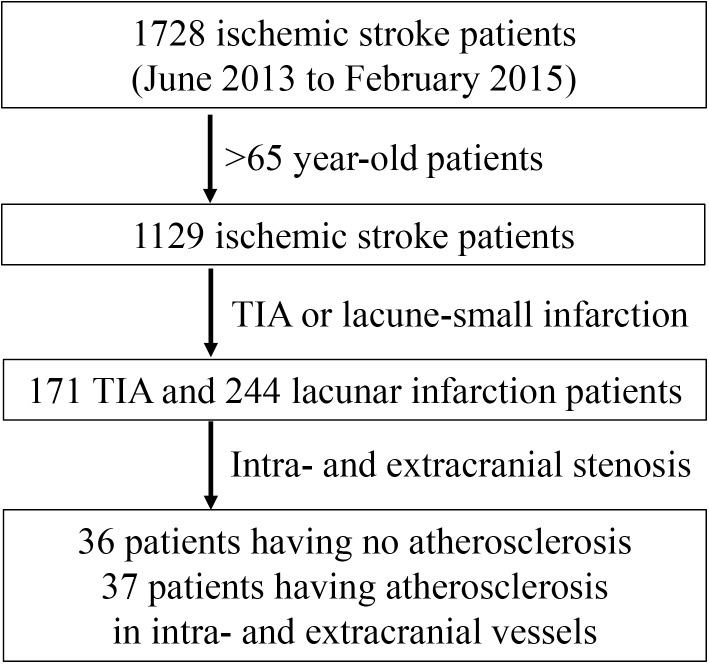
Flow diagram of patient enrollment from the Human Bio-Resource Bank of Chungnam National University Hospital.